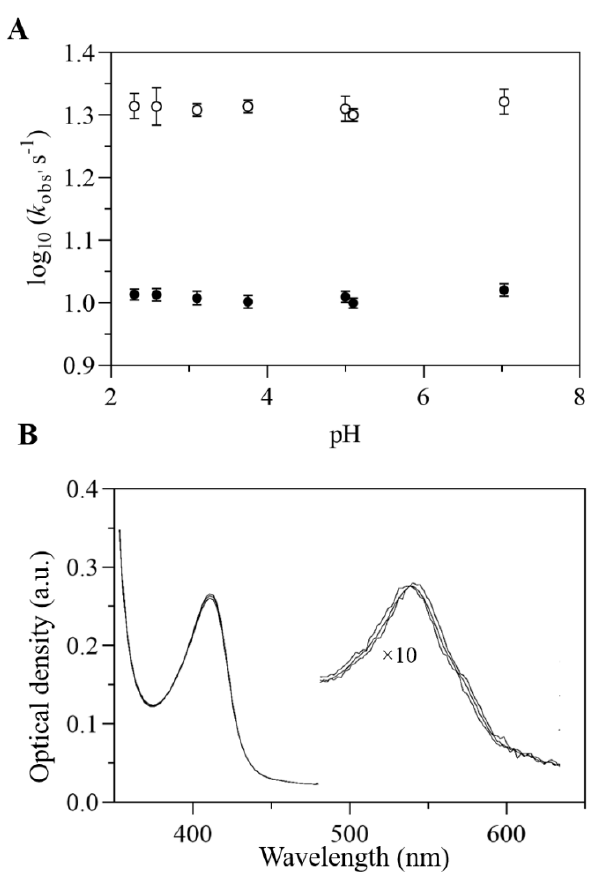
Figure 5. pH effect on CO binding rate constants. ( A ) Dependence on pH values of pseudo-first- order rate constants for CO binding to Mt -Nb(II) (filled circle) and Hs -Nb(II) (open circle) at 25.0 °C. [CO] = 2.0 × 10 −4 M after mixing. ( B ) Absorption spectra of unliganded Mt -Nb(II) at different time intervals (i.e., 3 ms, 0.1 s and 1 s) after mixing with 0.3 M phosphate pH 2.0 at 25.0 °C; final pH value was 2.3. Visible absorption spectra have 10-fold amplified.